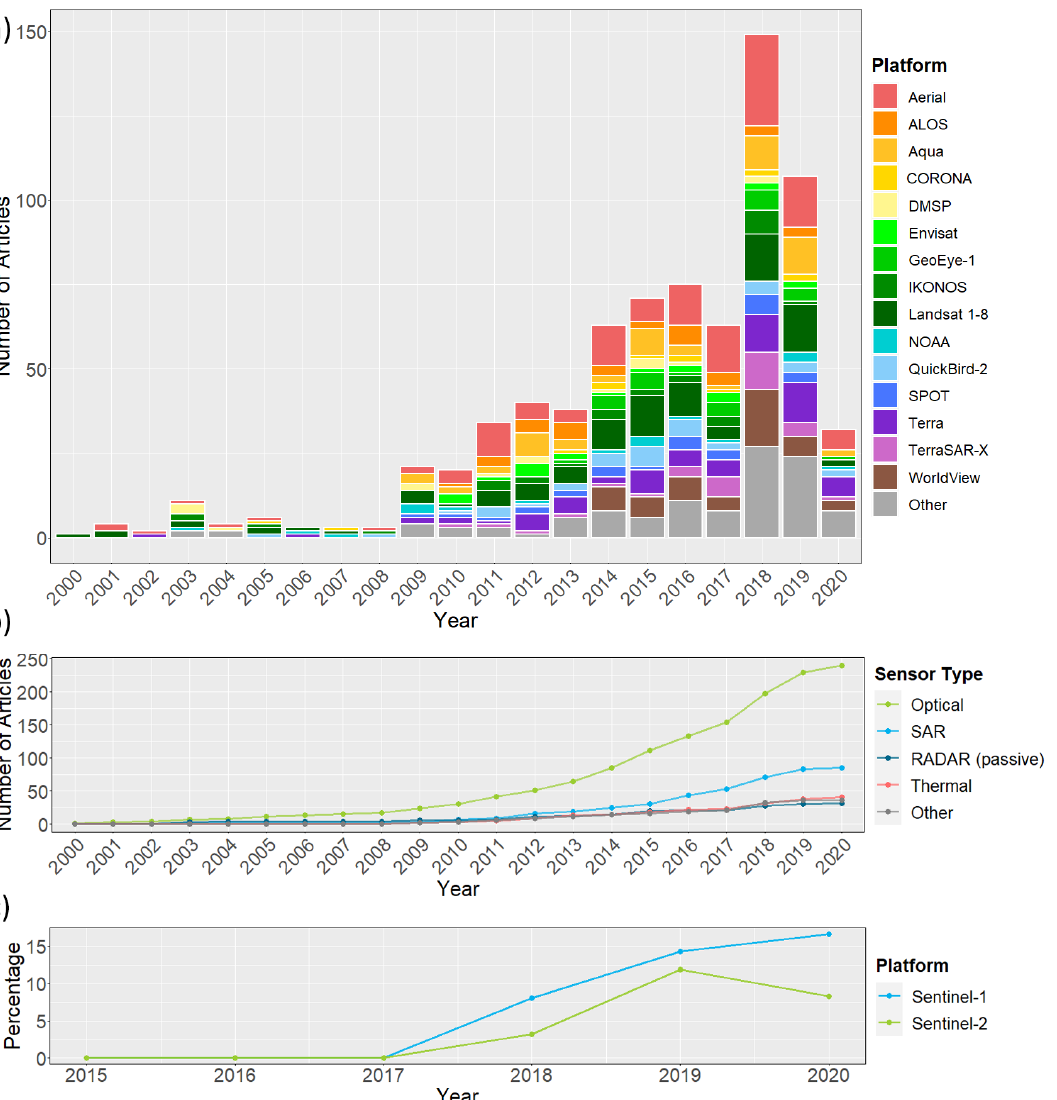
Figure 14. ( a ) Temporal development of the top 15 utilized remote sensing platforms within the reviewed articles over the past two decades. Several articles used data from multiple platforms. ( b ) Cumulative sum of applied sensor types over the past two decades. ( c ) Percentage of articles per year that utilized Sentinel imagery during the last five